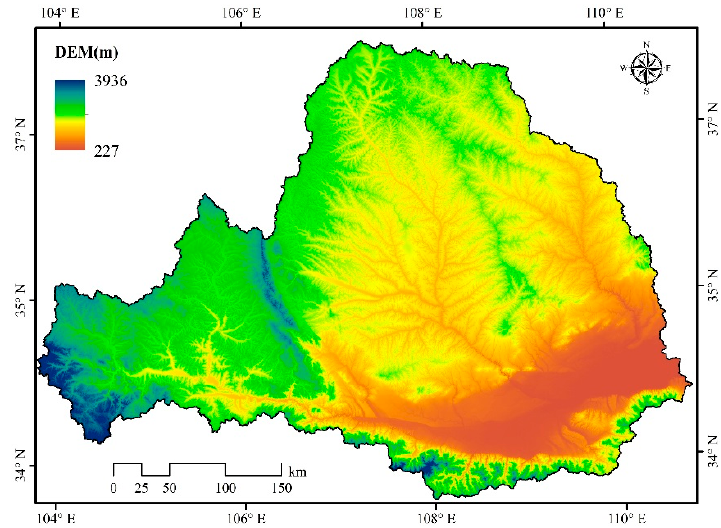
Figure 1. Elevation of the Wei River basin.